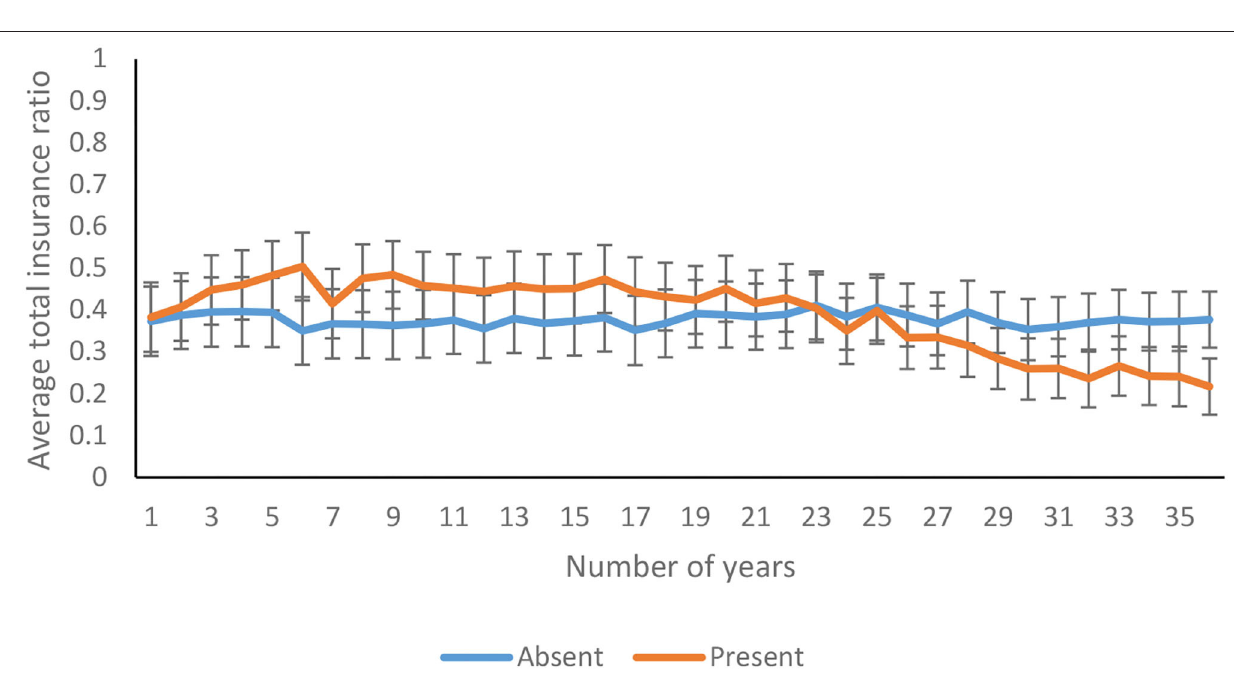
FIGURE 10 | Average total insurance ratio over years in feedback-present and absent conditions. The error bars show 95% CI around the point